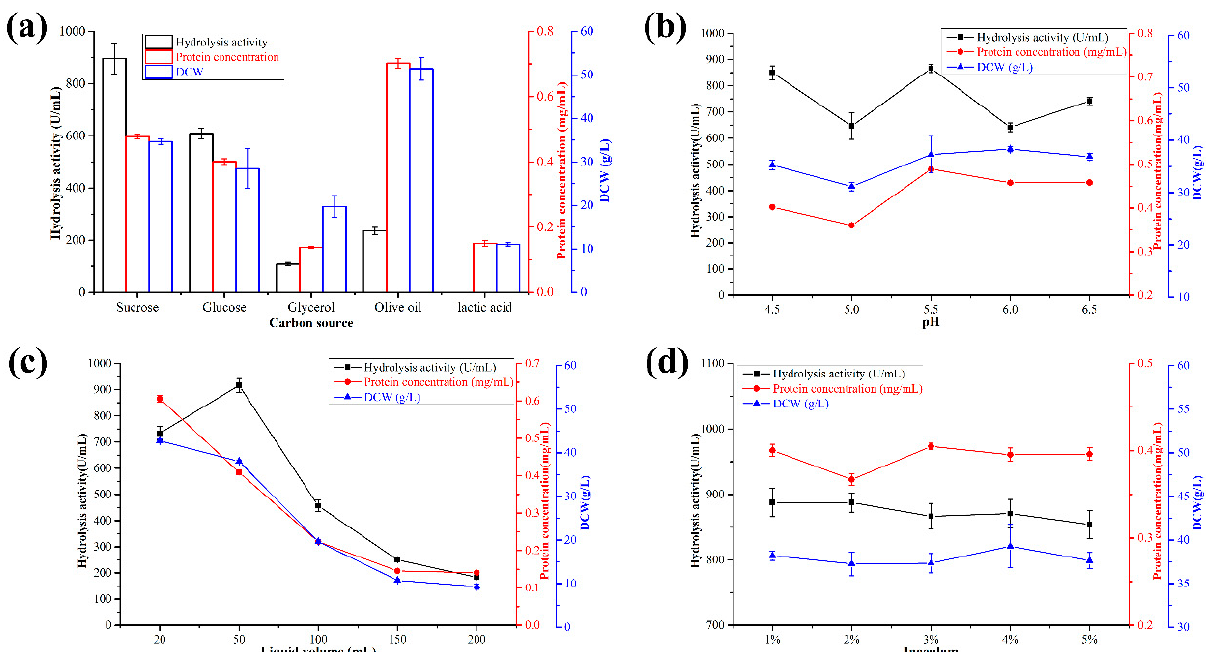
Figure 1. Optimization of the best engineered Y. lipolytica strain cultivation in 500 mL shake flasks. Effects of ( a ) different carbon sources in culture media on lipase hydrolysis activity, single-cell proteins (SCPs), and total protein concentration; ( b ) variation in initial pH on lipase hydrolysis activity, SCPs, and total protein concentration; ( c ) different initial liquid volumes of culture medium on lipase hydrolysis activity, SCPs, and total protein concentration; and ( d ) inoculum size on lipase hydrolysis activity, SCPs, and total protein concentration. All values are mean ± SD from three independent experiments.